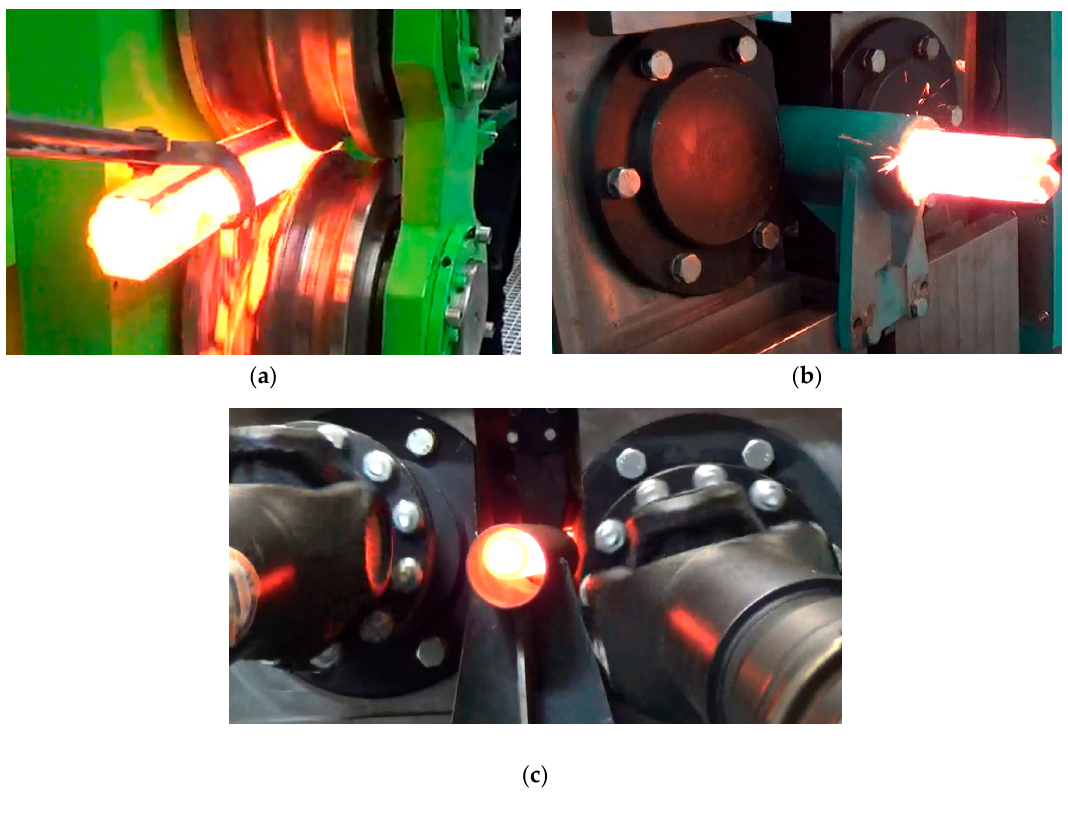
Figure 14. The sequential stages of rolling of rods from scrap rail heads: ( a ) rolling of the preform in the longitudinal mill; ( b ) feeding of the rolled preform to the skew mill; ( c ) a rod rolled in a helical pass, leaving the work space of the skew mill. Materials 2019 , 12 , x FOR PEER REVIEW